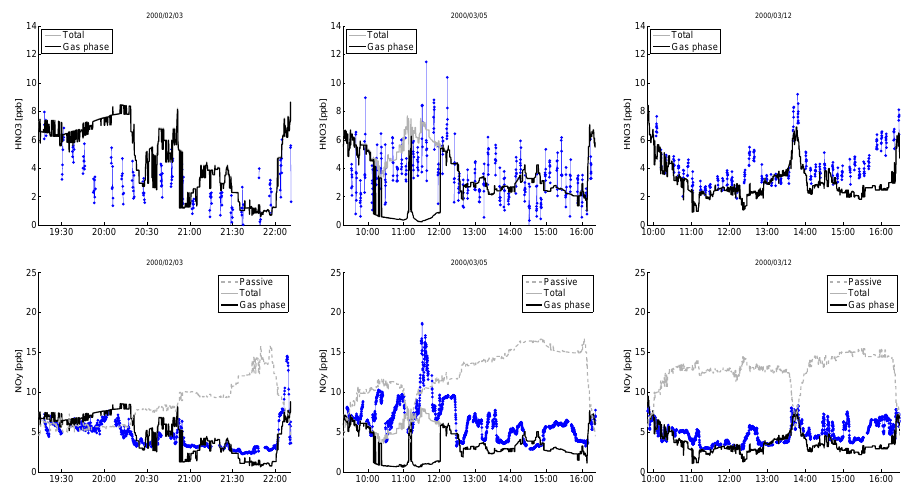
Fig. 6. HNO 3 (top) and NO y (bottom) as a function of flight time (UTC) from measurements of selected ER-2 flights (3 February, 5 March, 12 March) (blue dots) compared to modeled values (lines). NO y measurements give the total (solid and gas phase, for details see text) values, HNO 3 measurements show only the gas phase. The black line shows the model values for the gas phase, the grey line the total (solid not in the Lagrangian particles and gas phase) values and the dashed grey line the passive NO y tracer.